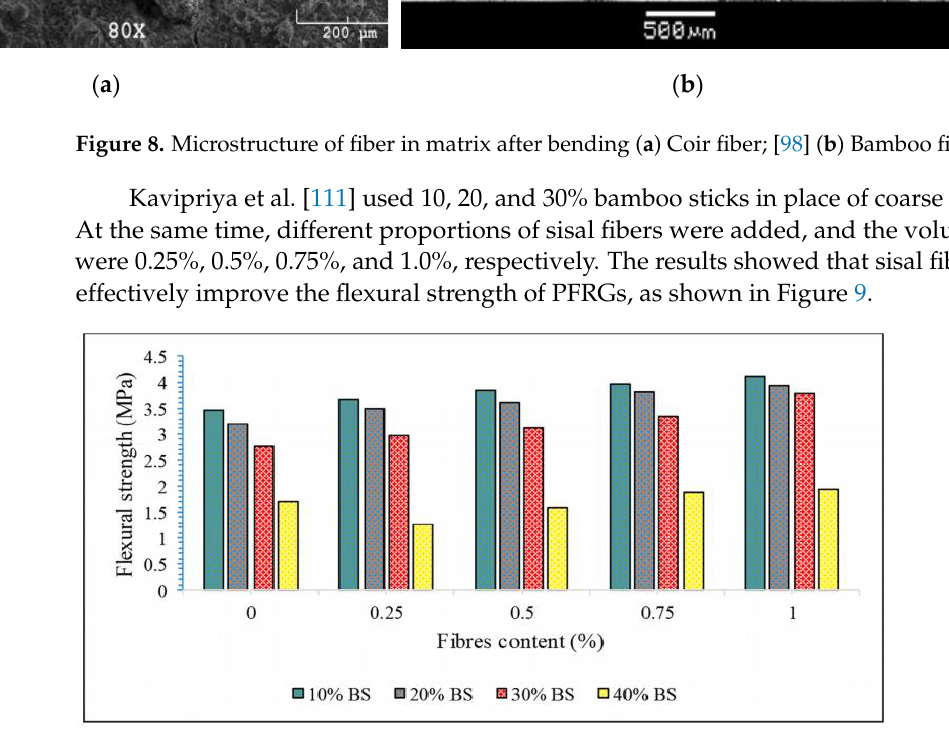
Figure 8. Microstructure of fiber in matrix after bending ( a ) Coir fiber; [98] ( b ) Bamboo fiber [110].